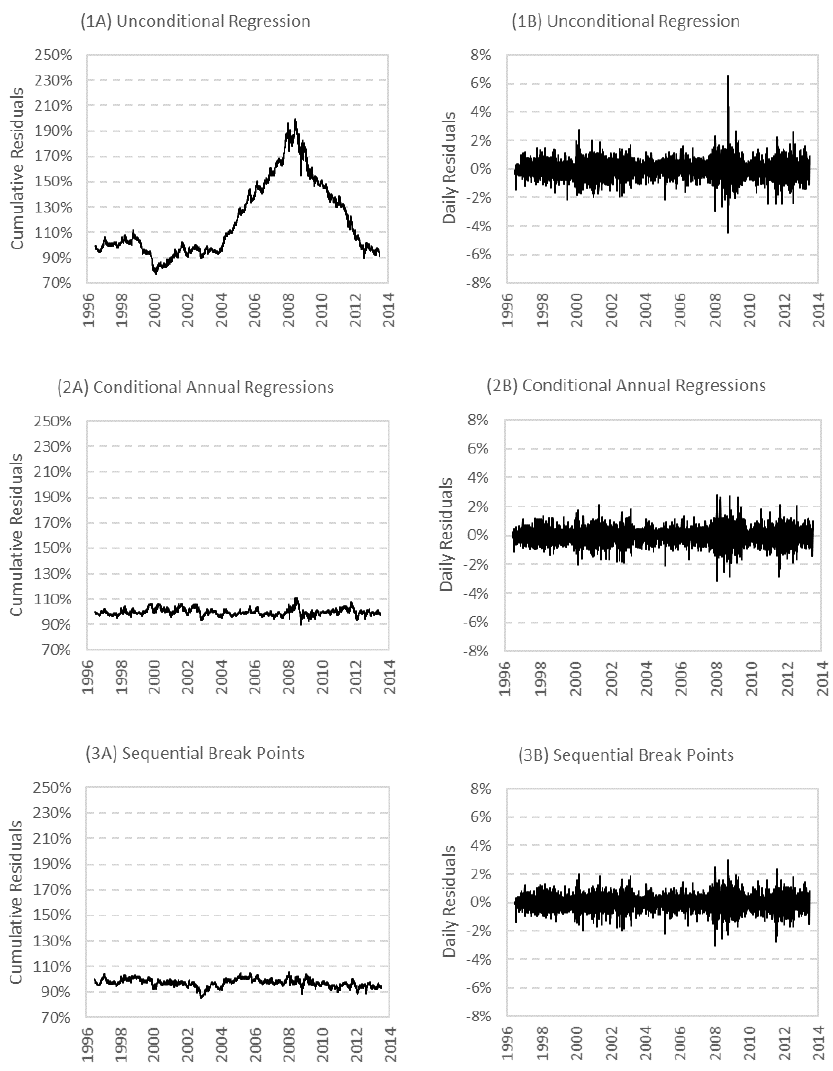
Figure 4. Cumulative and daily residuals of regression specifications. This figure illustrates the daily and cumulative residuals of three different local AFFM specifications: (1) the unconditional local AFFM (Plots 1A , 1B ), the conditional annual local AFFMs (Plots 2A , 2B ) and the sequential structural breakpoint tests (Plots 3A , 3B